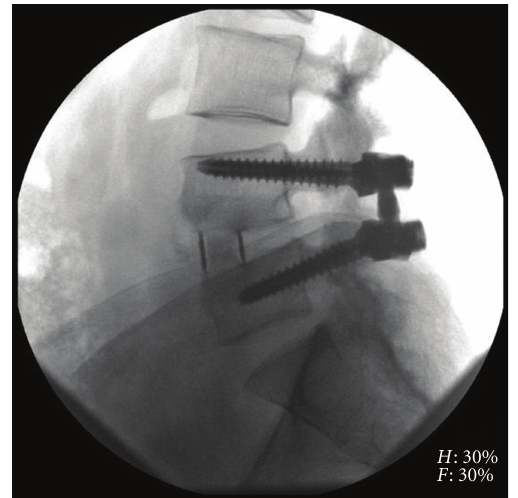
Figure 4: Lateral radiograph of L4-5 extreme lateral interbody fusion with Osteocel Plus at 12-month